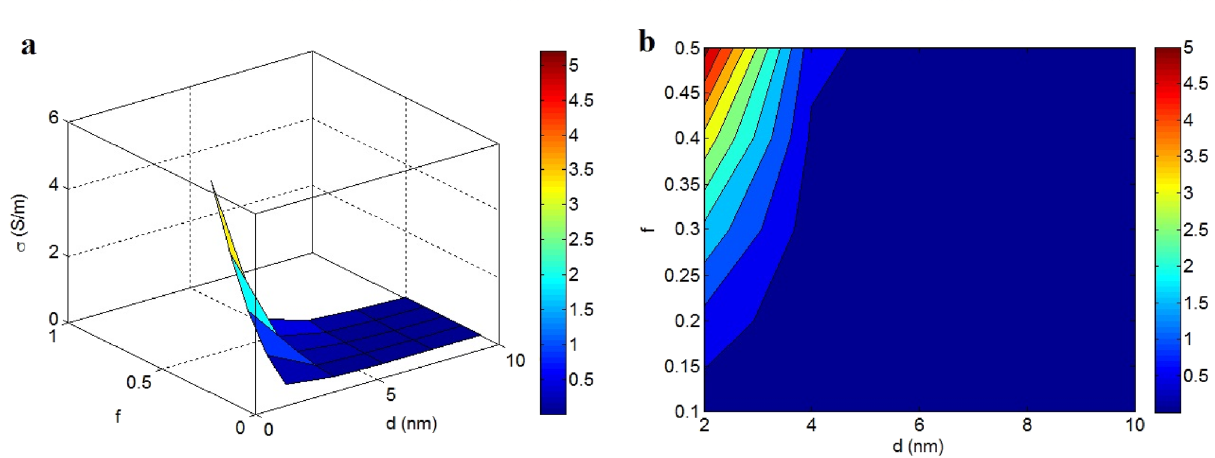
Figure 6. Disparity of conductivity by “d” and “f” applying ( a ) 3D and ( b ) contour